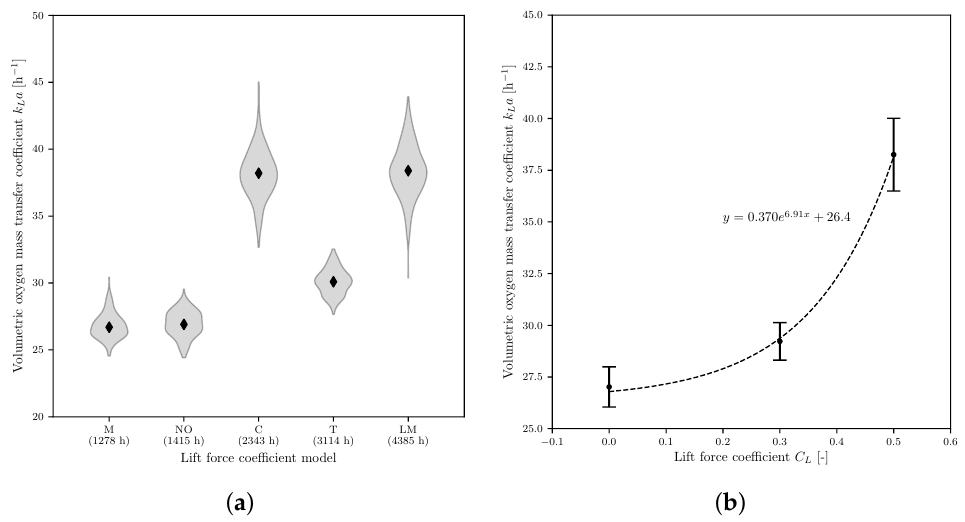
Figure 6. Influence of the lift force coefficient on the k L a value. ( a ) Effect of different lift force coefficient model on the k L a value. The mean values and the corresponding probability density function are shown in violin form. The time corresponds to the CPU time for the simulation of 20 s (M = Moraga, NO = no lift coefficient, C = constant lift coefficient 0.5, T = Tomiyama [81], LM = Legendre and Magnaudet [82]); ( b ) Influence of different constant lift force coefficient on the k L a